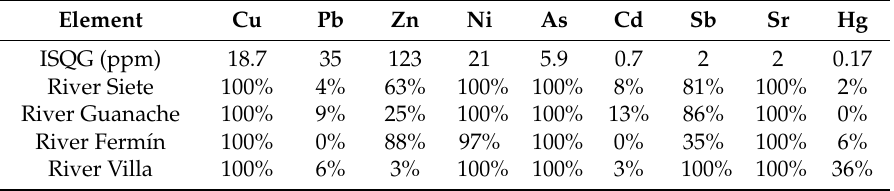
Table 4. Percentage of samples above the guidelines for sediment quality (ISQG)